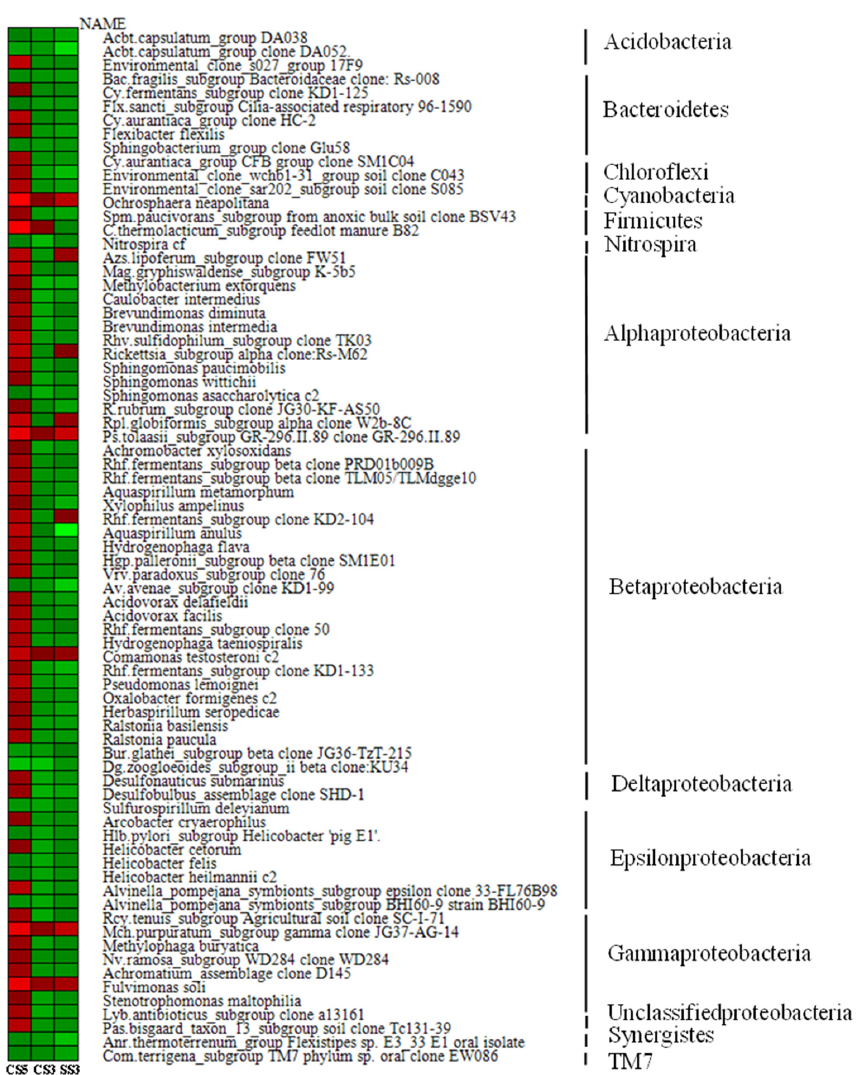
Figure 6. Heatmap showing the top 50 most abundant genera of bacterial community for each sample.